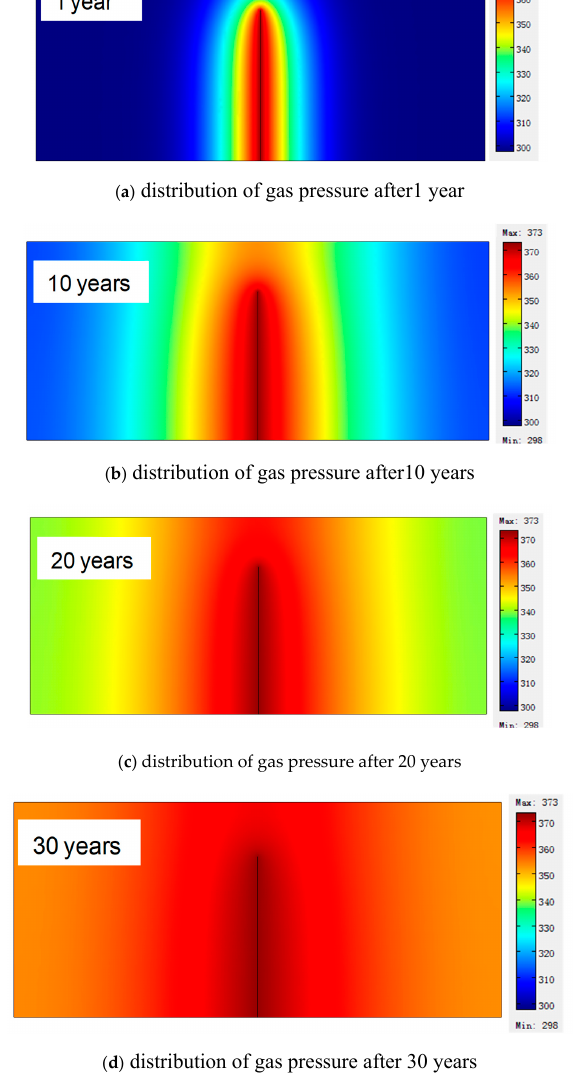
Figure 7. Distribution of gas pressure (MPa) after different production times.